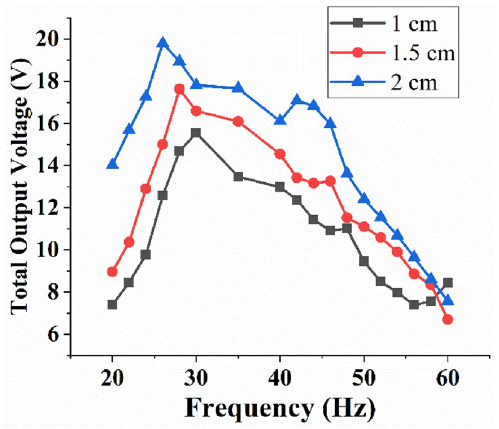
Figure 8. Effect of extension lengths on the total output voltage of MT-HPTEH.